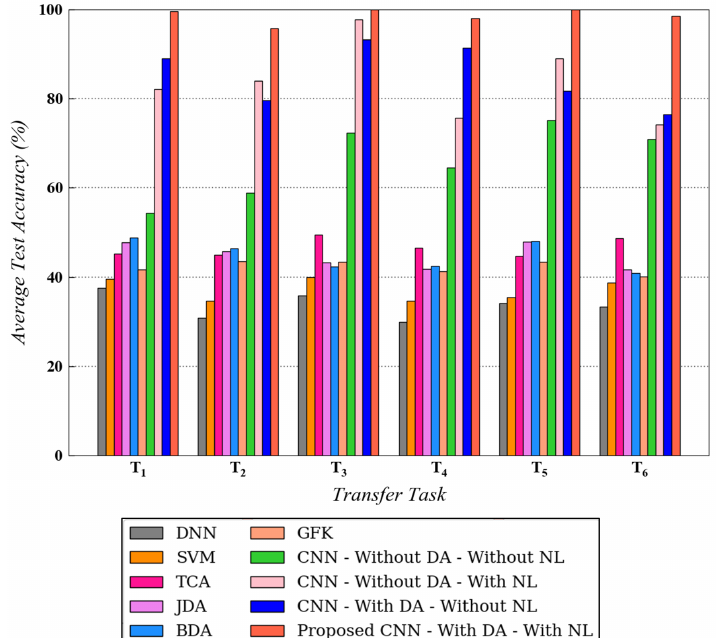
Figure 7. Testing diagnosis performances on target domain for different transfer tasks using different algorithms on CWRU dataset. N S = 100 is